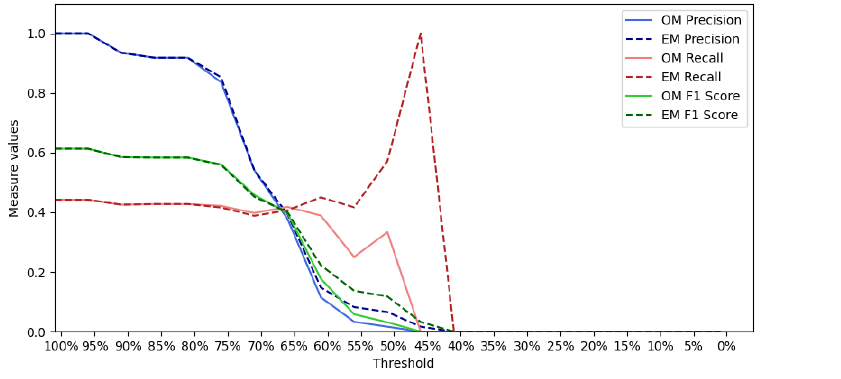
Figure 15. Results of the event “Gurlitt”.